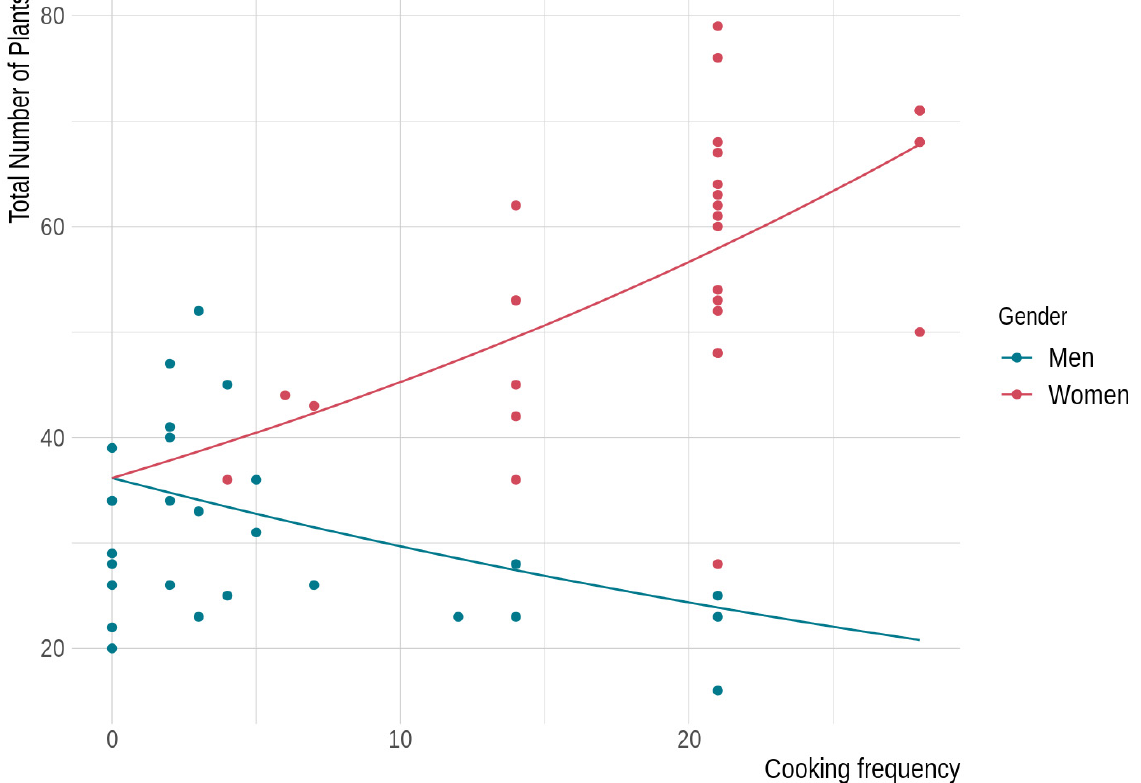
Figure 1. Number of elicited items according to frequency of cooking (number of times that the participant prepares a meal per week) per men and women. Trends are based on the GLM with interactions (see full model and results in Table S4).